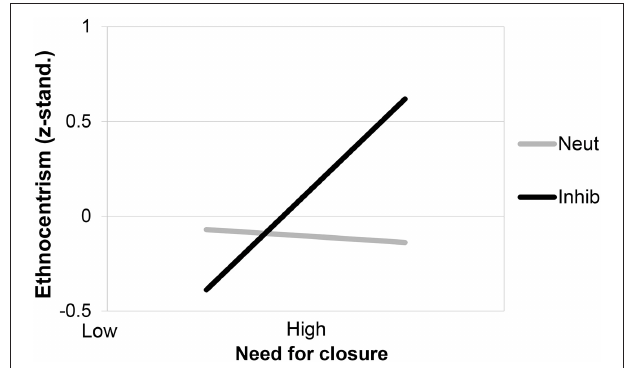
FIGURE 6 | Ethnocentrism as a function of need for closure (NFC) and Inhibition (Inhib). Neut, neutral control topic.